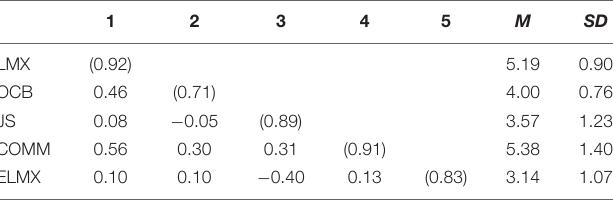
TABLE 9 | Correlations, alphas, means, and standard deviations (Study